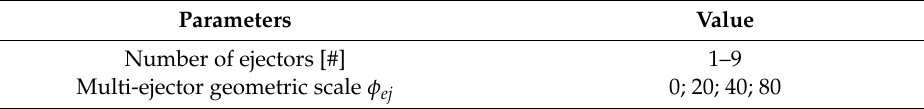
Table 4. Multi-ejector pack